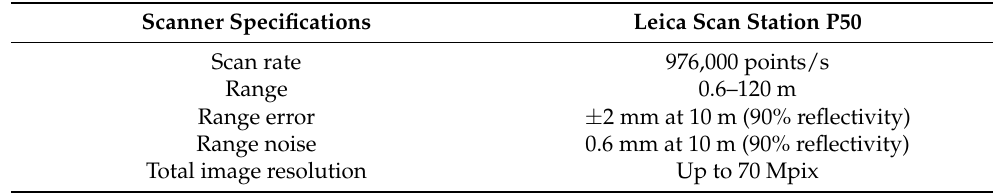
Figure 9. UAV flight route to gather oblique images. Lines represent the drone flight path; dots represent image capture positions on the flight path. Table 2. Specifications and parameters for the TLS.